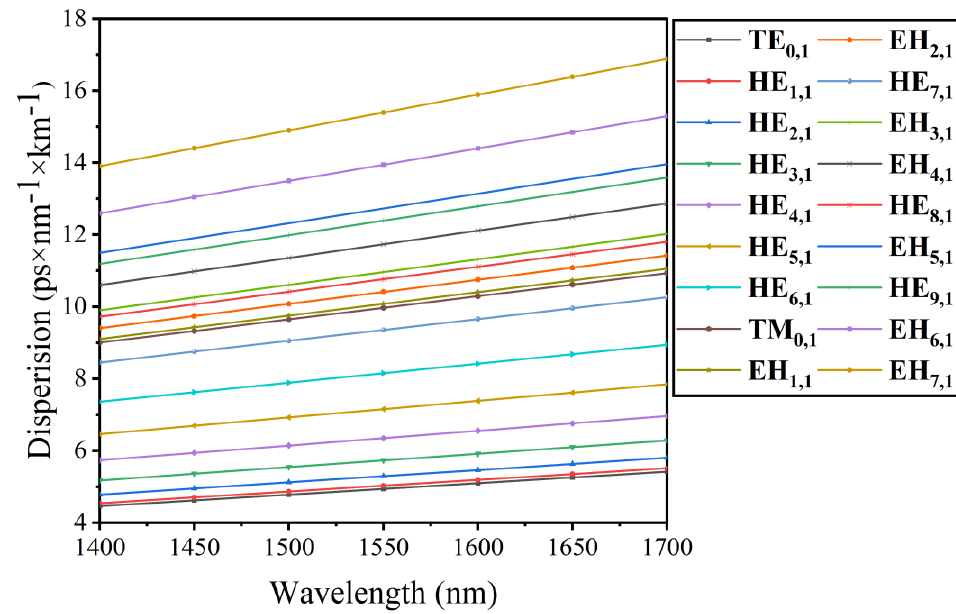
Figure 8. The relation between dispersion and wavelength in different vector modes.